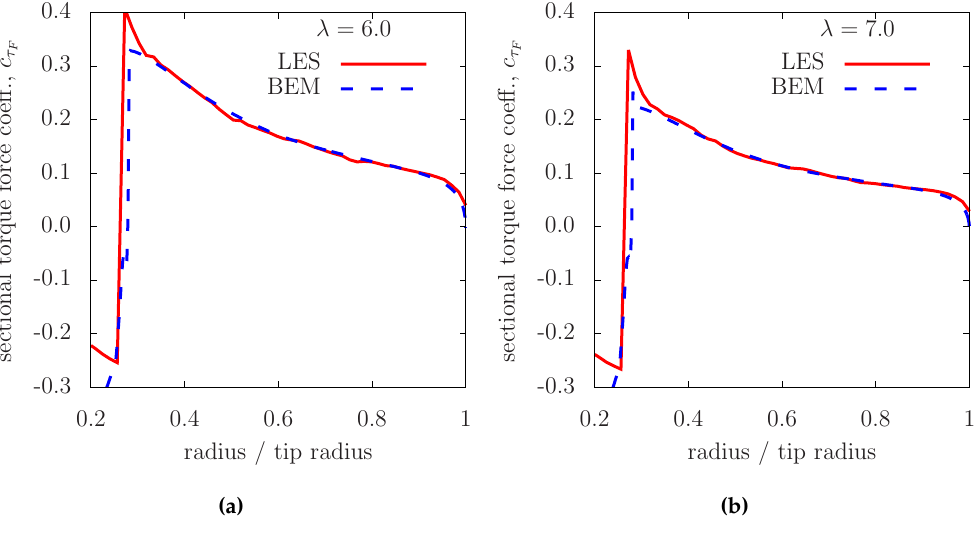
Figure 3. Radial variation of sectional torque force coefficient, c τ simulations (LES) and BEM theory predictions at ( a ) λ = 6.0 and ( b ) λ =